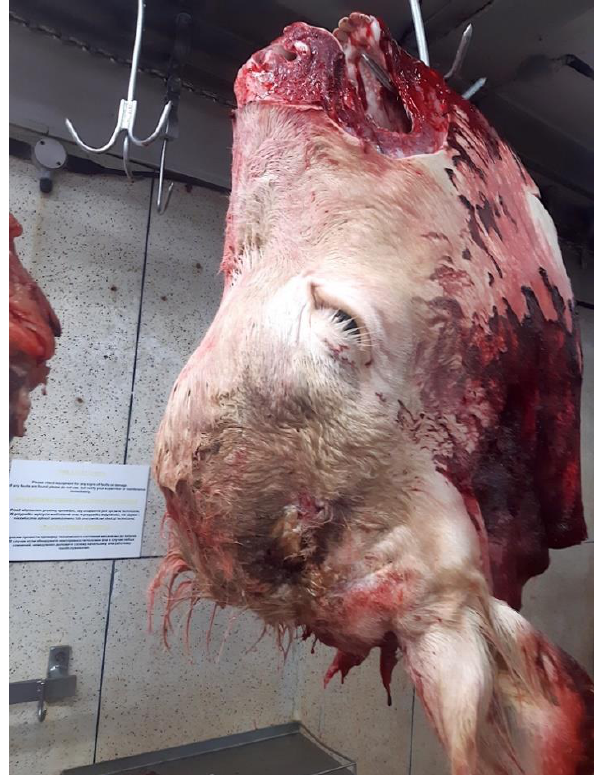
Figure 1. The head removed from carcass (Right Hand Side).